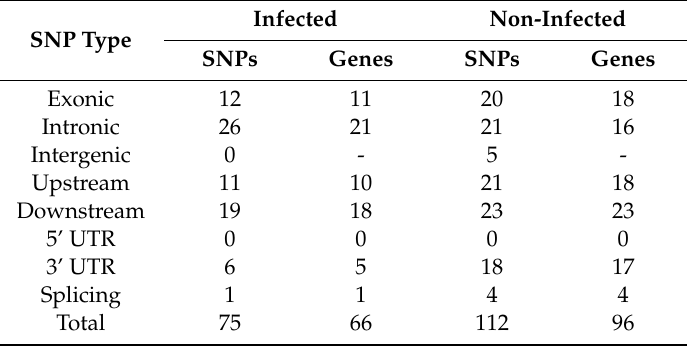
Table 5. Classification of ASE SNPs between two reciprocal crosses.